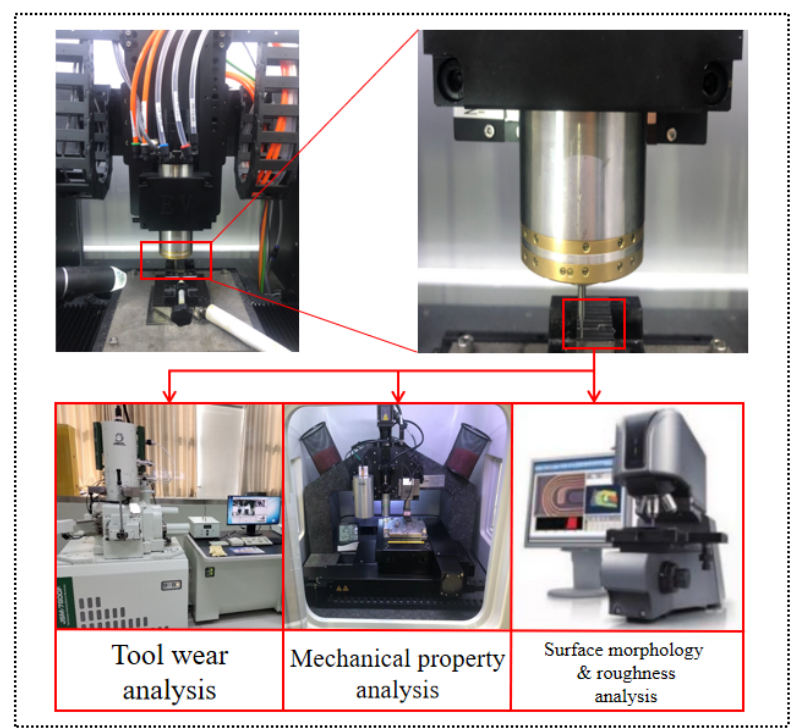
Figure 1. The experimental devices.